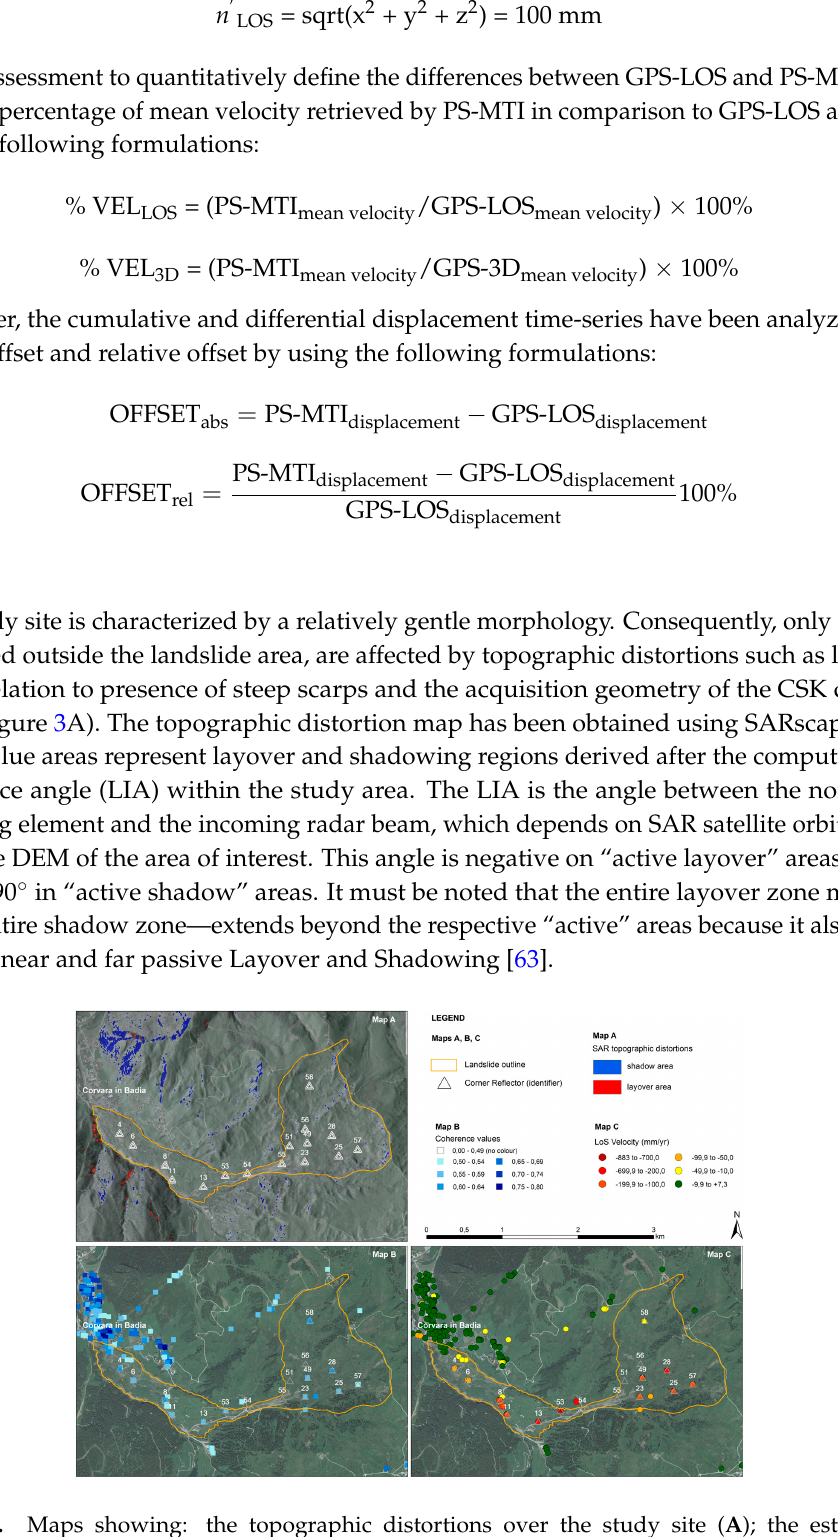
Figure 3. Maps showing: the topographic distortions over the study site ( A ); the estimated interferometric coherence across the landslide area ( B ); and the annual velocities observed both within and outside the landslide boundaries ( C ).